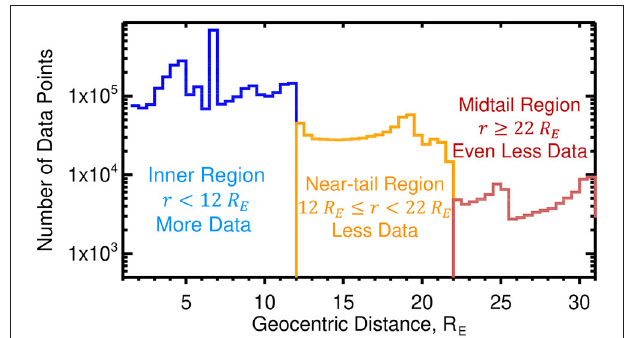
FIGURE 1 | Radial distribution of magnetometer data. A histogram showing the radial distribution of the magnetometer database using r bins. The database covers three distinct regions with differing numbers of data points: the inner (blue), near-tail (orange), and midtail (brownish-red)